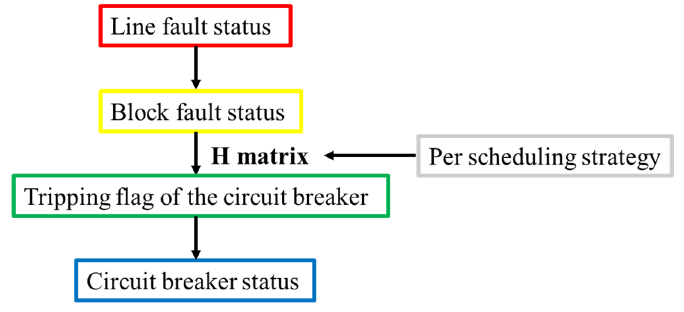
Figure 4. Line fault consequence model in distribution network.